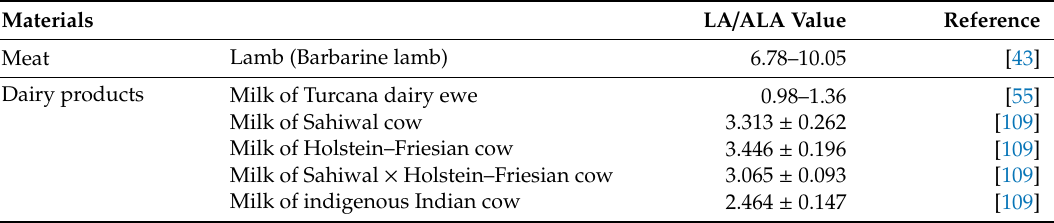
Table 10. Application of LA / ALA in fatty acid evaluation